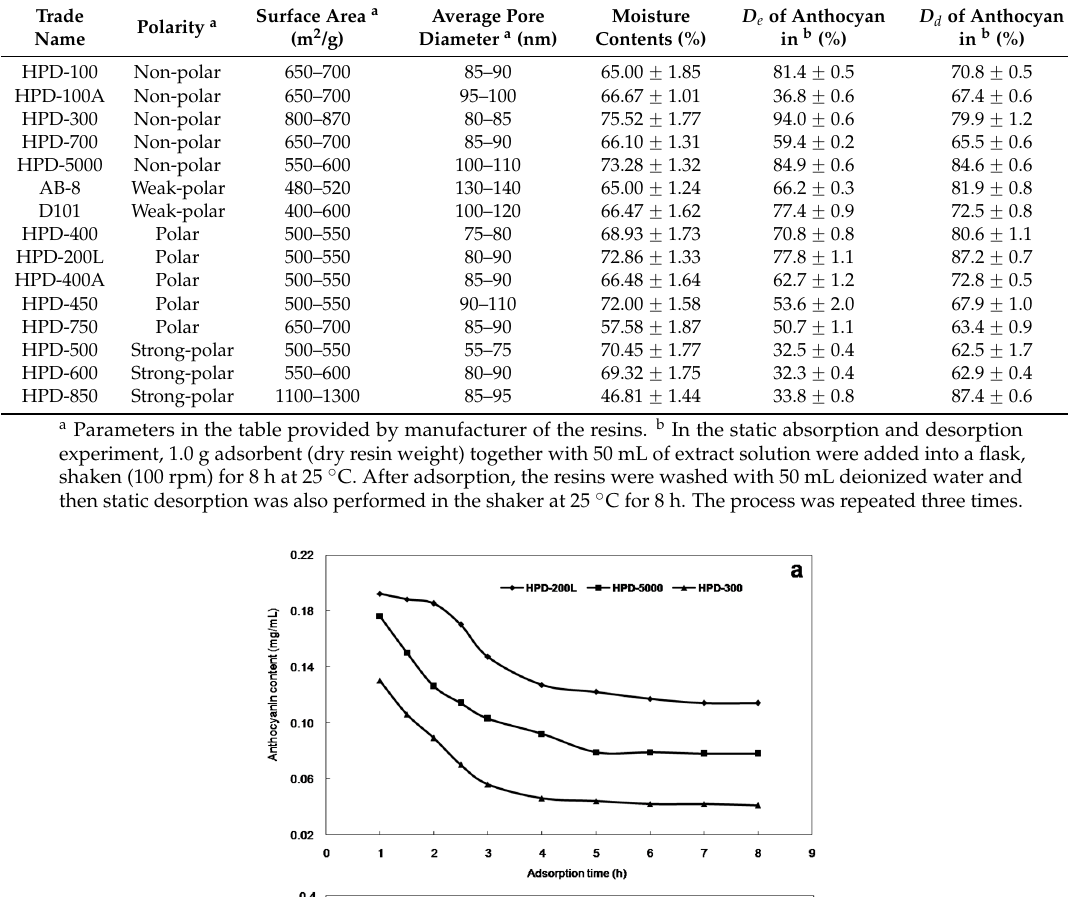
Table 1. Physical properties and static adsorption-desorption characteristics of the test macroporous resins.